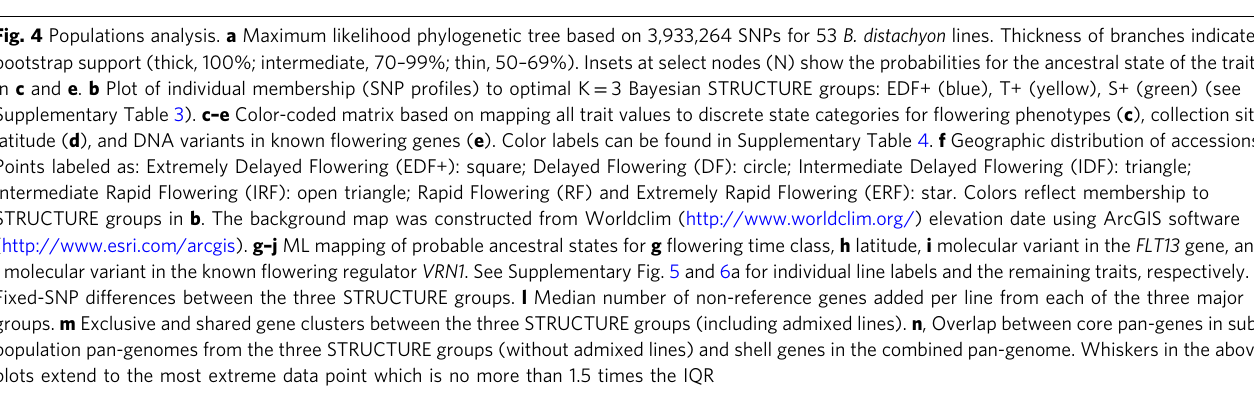
Fixed-SNP differences between the three STRUCTURE groups. l Median number of non-reference genes added per line from each of the three major groups. m Exclusive and shared gene clusters between the three STRUCTURE groups (including admixed lines). n , Overlap between core pan-genes in sub- population pan-genomes from the three STRUCTURE groups (without admixed lines) and shell genes in the combined pan-genome. Whiskers in the